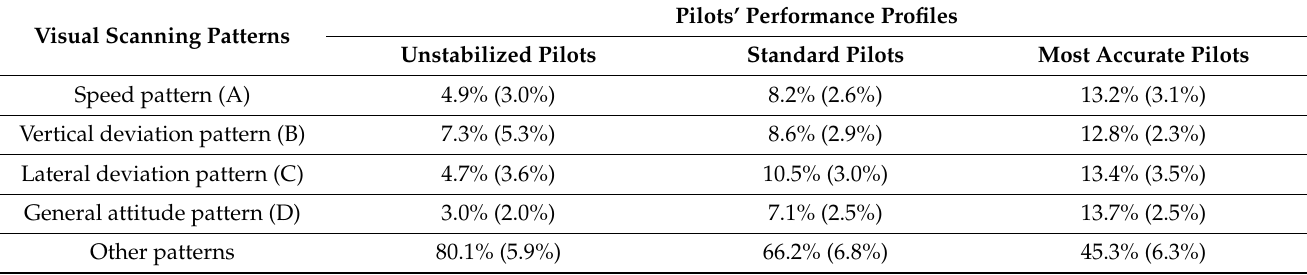
Table 1. Mean (SD) proportion of the four efficient visual scanning patterns according to the three pilot’s performance profiles. See Table S3 in Supplementary Material for individual